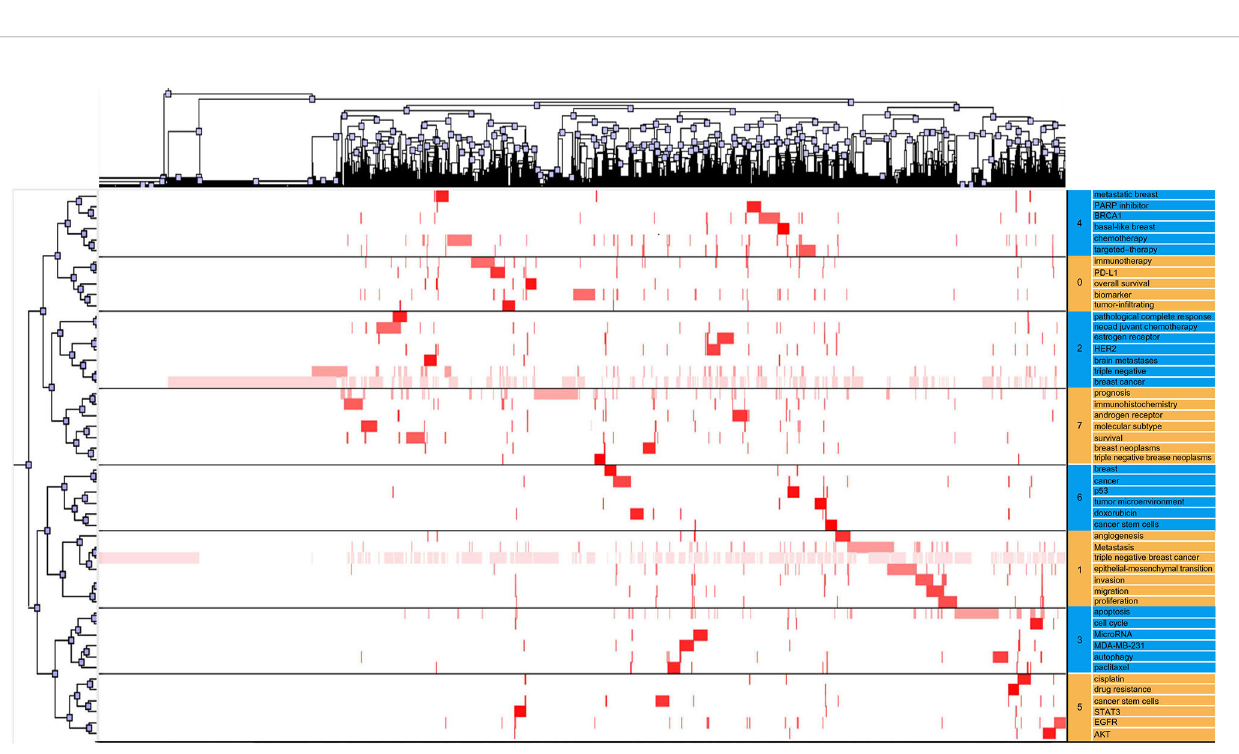
FIGURE 4 | Visualized Mountain Map based on the Biclustering analysis of TNBC Binary Matrix of Word-paper. Cluster 0: Immunotherapy for TNBC. Cluster 1: The role of EMT in TNBC tumor cell metastasis; Cluster 2: The effect of neoadjuvant chemotherapy in TNBC treatments; Cluster 3: The Application of Paclitaxel in TNBC Treatments; Cluster 4: PARP inhibitors in TNBC treatments. Cluster 5: Tumor stem cell studies of TNBC; Cluster 6: Tumor microenvironment of TNBC; Cluster 7: Molecular subtypes of TNBC.